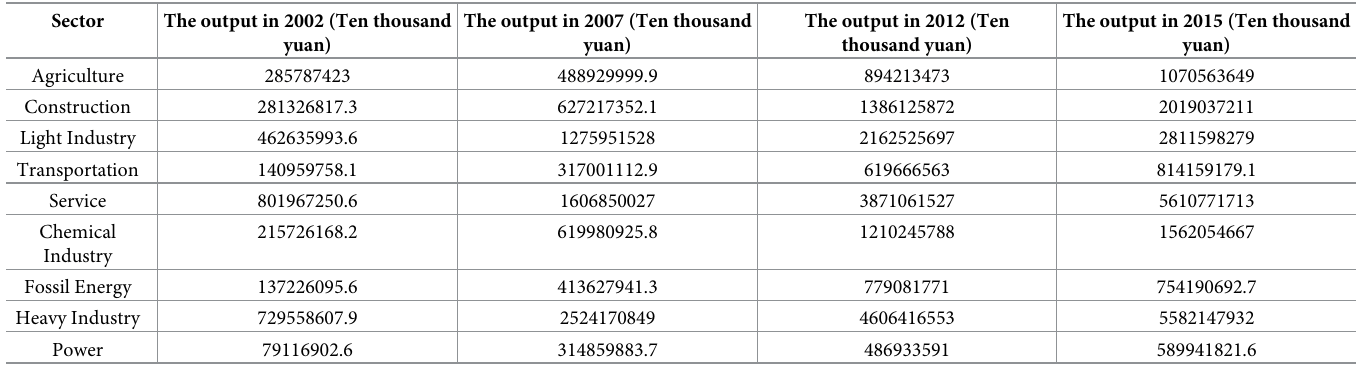
Table 9. The output of the combined nine major sectors in 2002–2015.